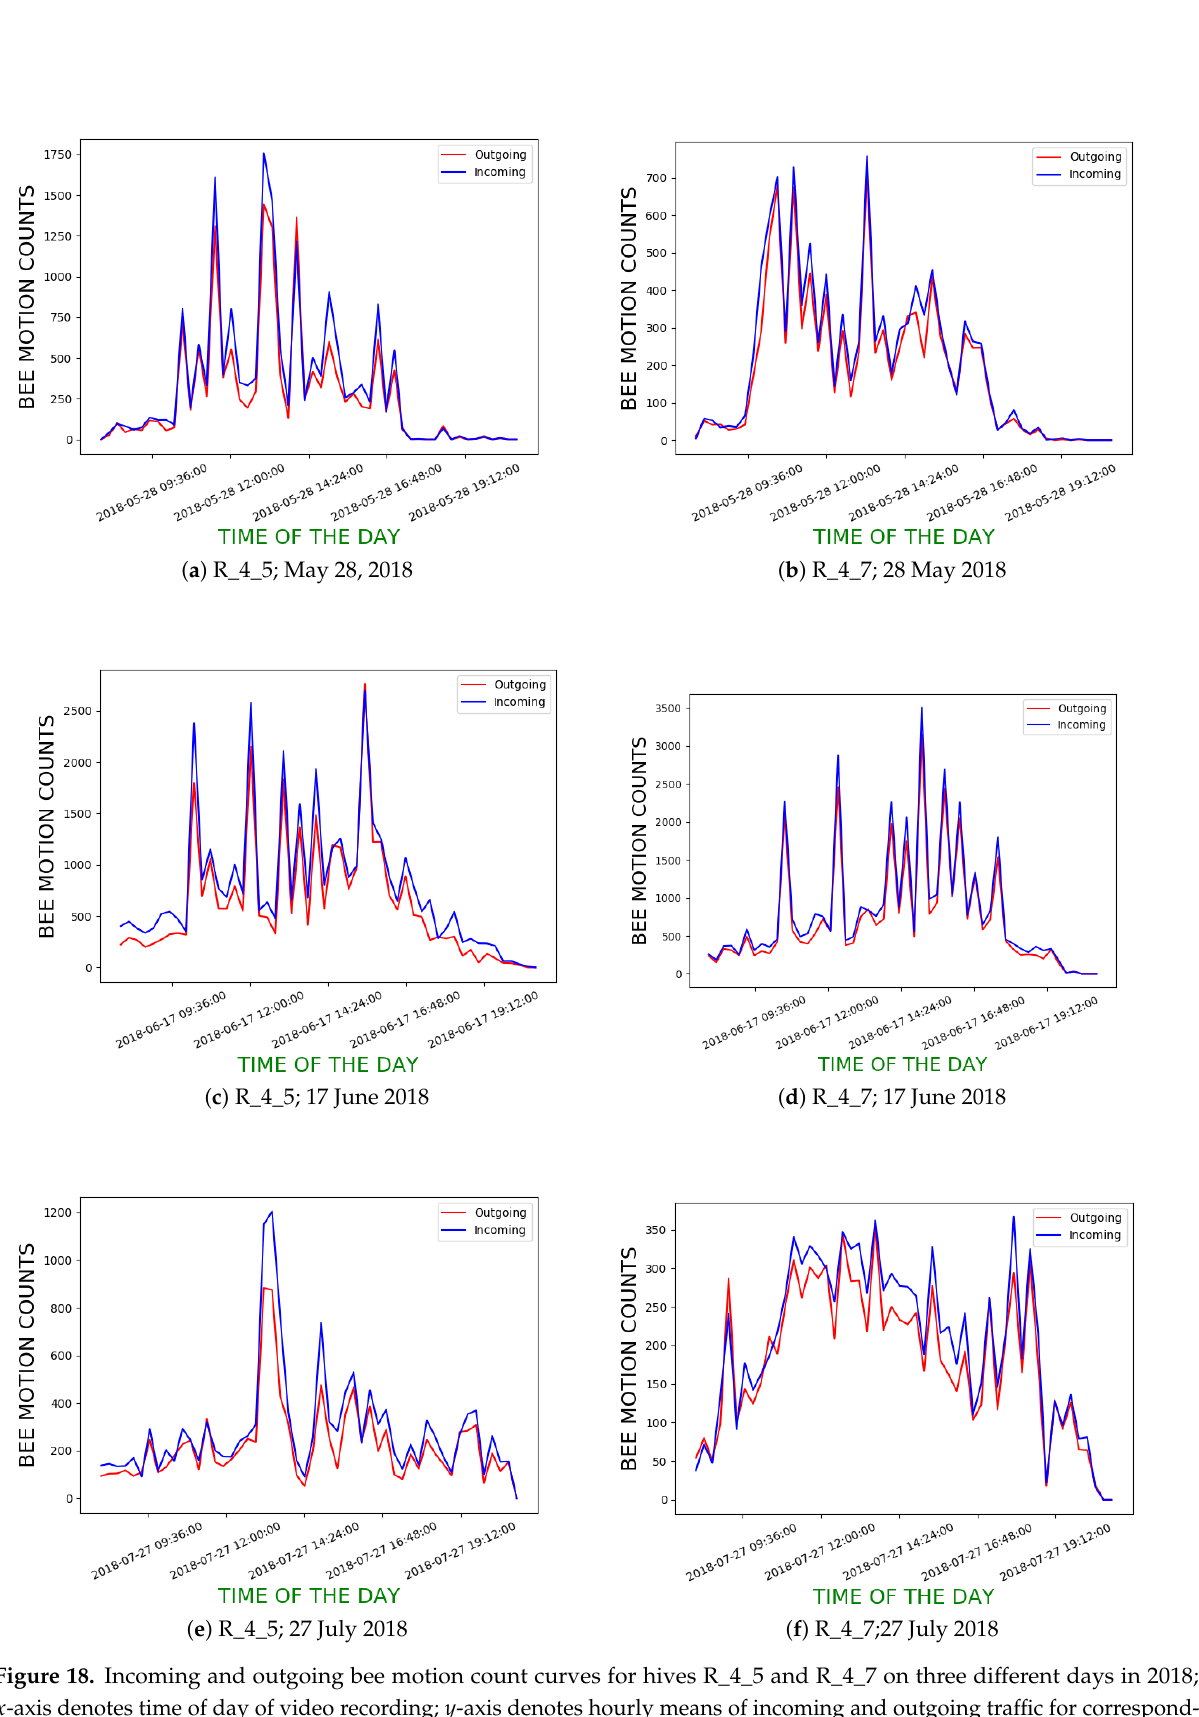
Figure 18. Incoming and outgoing bee motion count curves for hives R_4_5 and R_4_7 on three different days in 2018; x -axis denotes time of day of video recording; y -axis denotes hourly means of incoming and outgoing traffic for correspond- ing